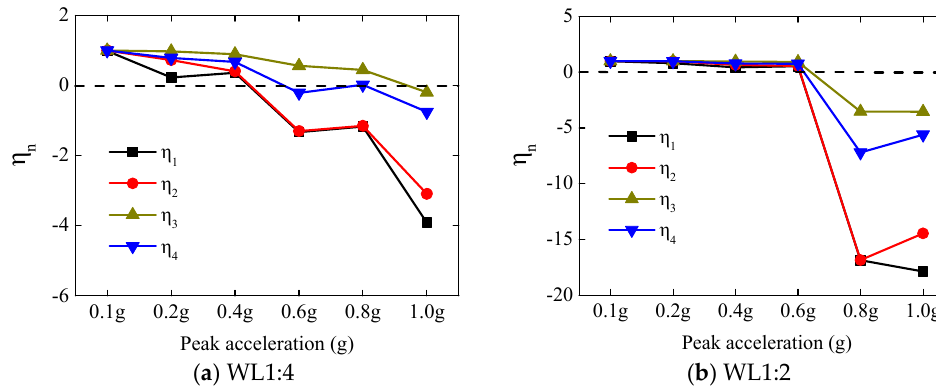
Figure 9. Muni method [16] under WL wave η n value.